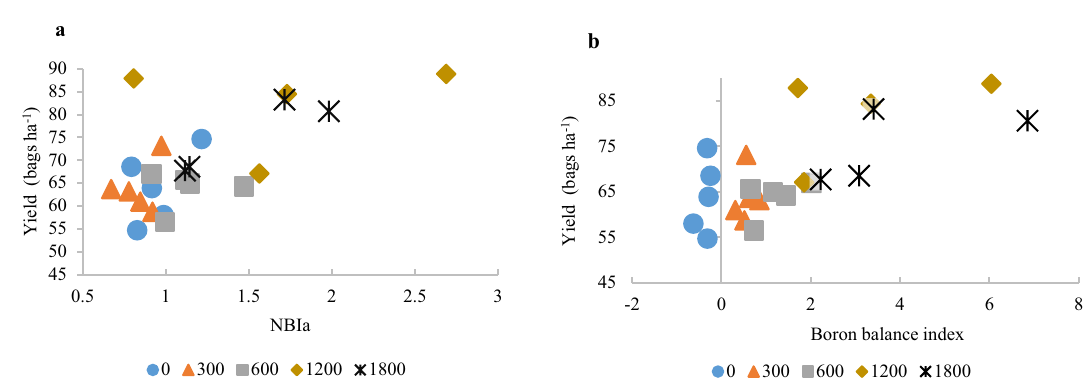
Figure 1. Relationship between soybean yield and the Average Nutrient Balance Index (NBIa) ( a ) and the boron balance index ( b ) obtained by the DRIS method using all bivariate relationships (DrisAll) for the sampled dataset for soybean, cultivated in Chapadão do Sul, Mato Grosso do Sul, Brazil.